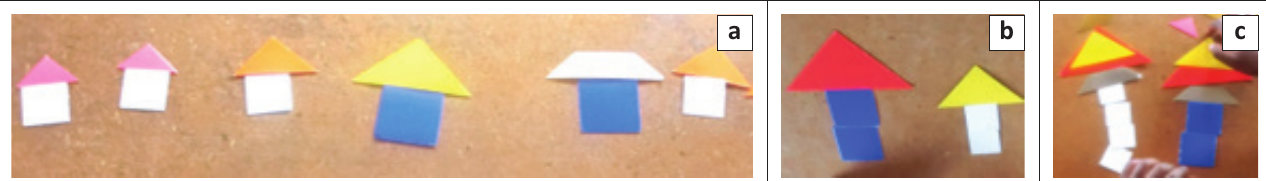
children made squares, combining right-angled triangles